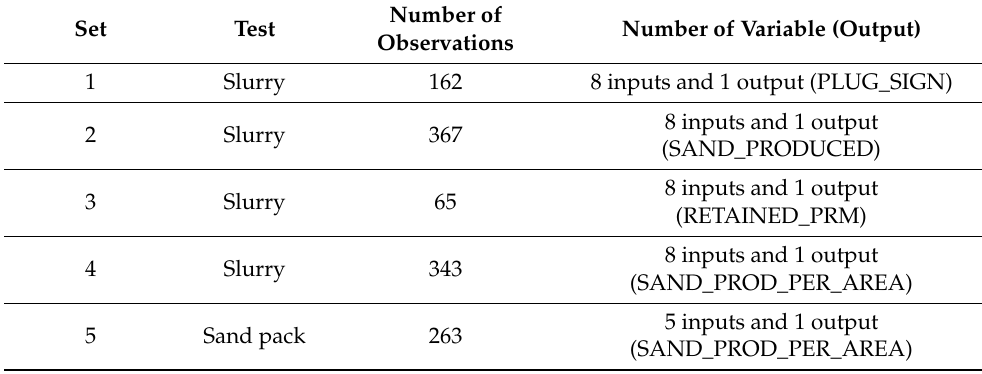
Table 2. Set of data used to train